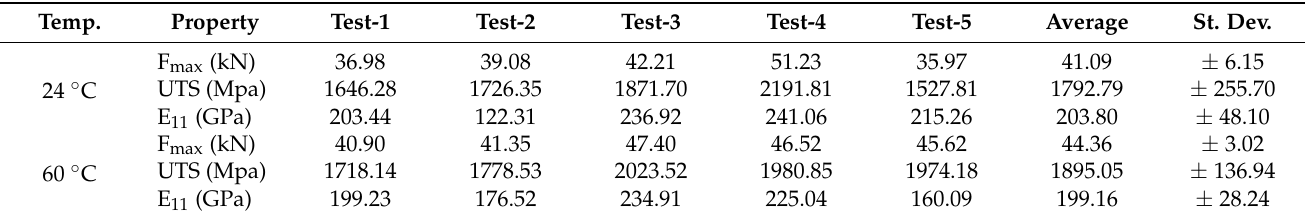
Table 4. Estimated values of maximum force (F max ), ultimate tensile strength (UTS) and longitudinal modulus (E 11 ) for the SS tests at 24 and 60 ◦ C. Temp.